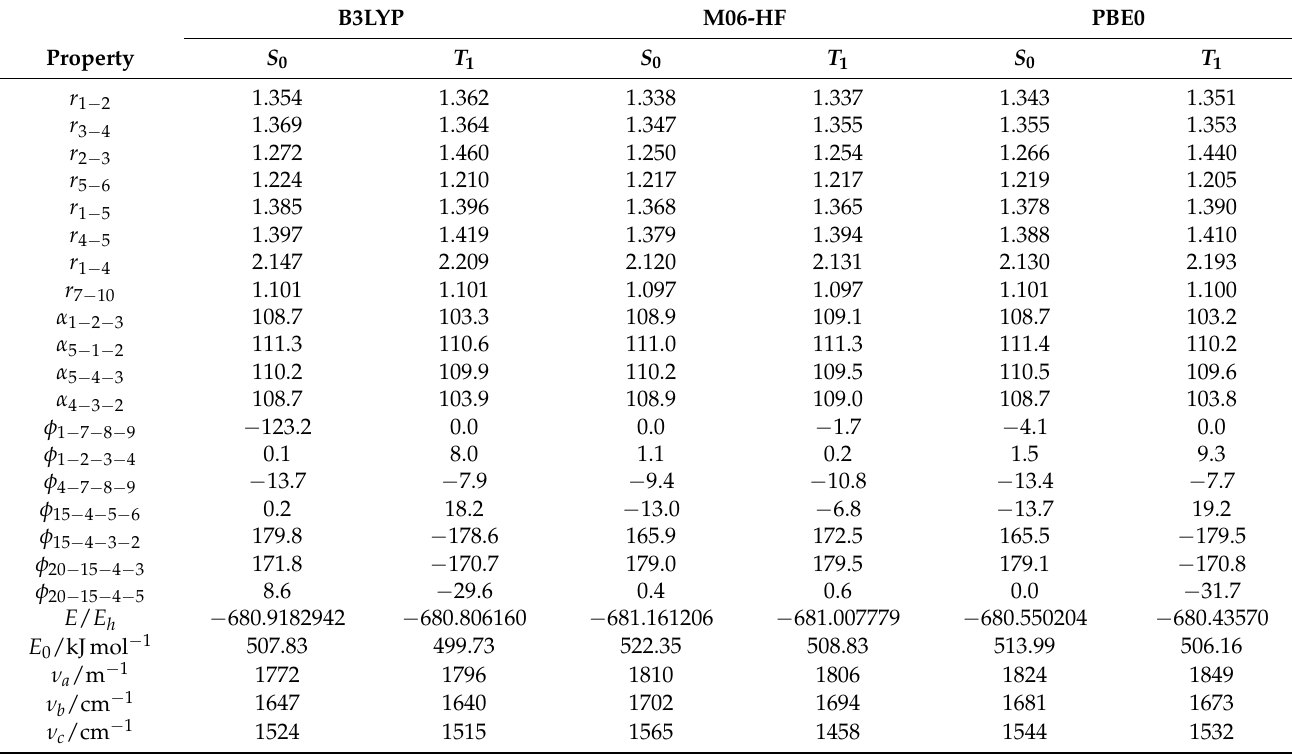
Table 1. Main structural parameters of optimised geometries of ATZ in the ground ( S 0 ) and triplet ( T 1 ) states using PCM. Distances are in Angstrom and angles in degrees. For a complete description of the molecule degrees of freedom see Supplementary